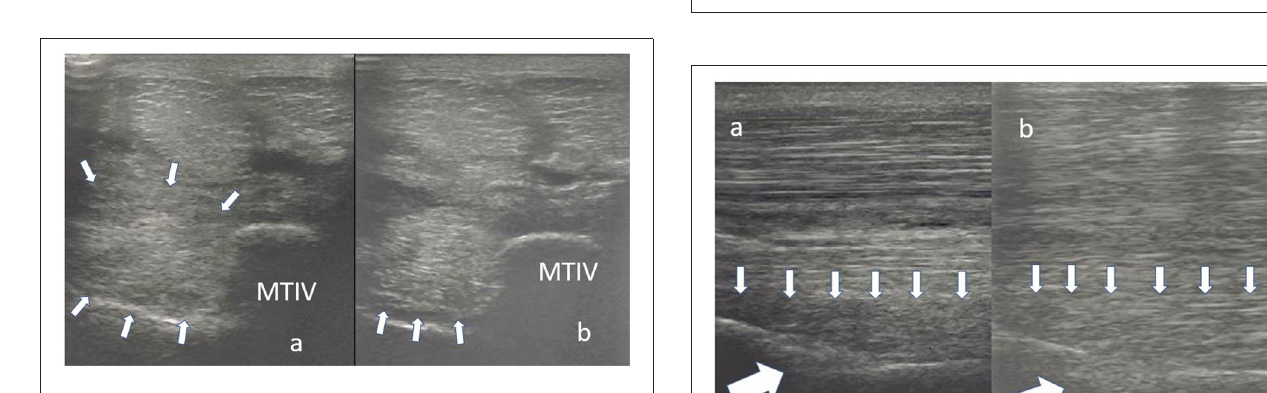
FIGURE 7 | Transverse images of a proximal suspensory ligament about 3cm distal the head of the MTII. In panel (a) , the dorsal, hypoechogenic lesion (white arrows) occupies more than 50% of the cross-sectional area of the ligament. In panel (b) , there is an obvious increase in echogenicity of the dorsal aspect of the ligament. This horse was treated with BMAC and was not lame 18 months post-treatment.